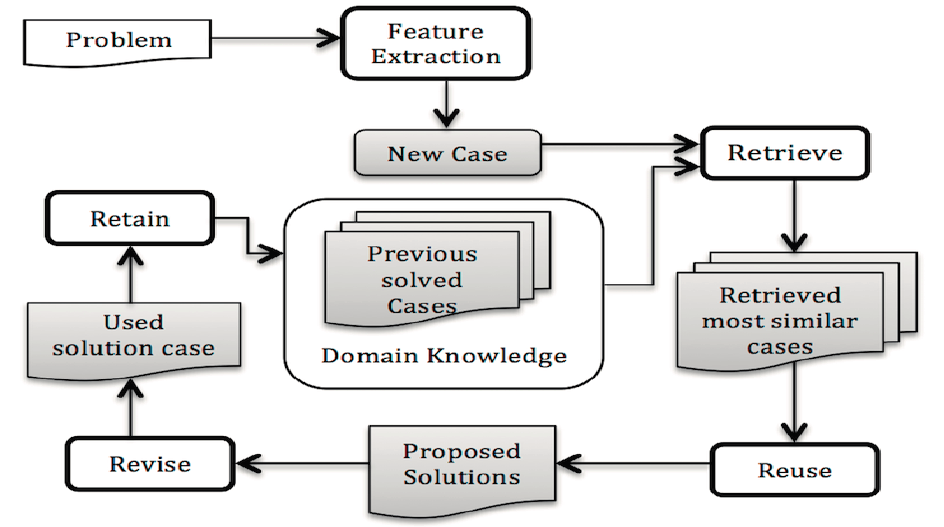
Figure 2. CBR cycle adapted from